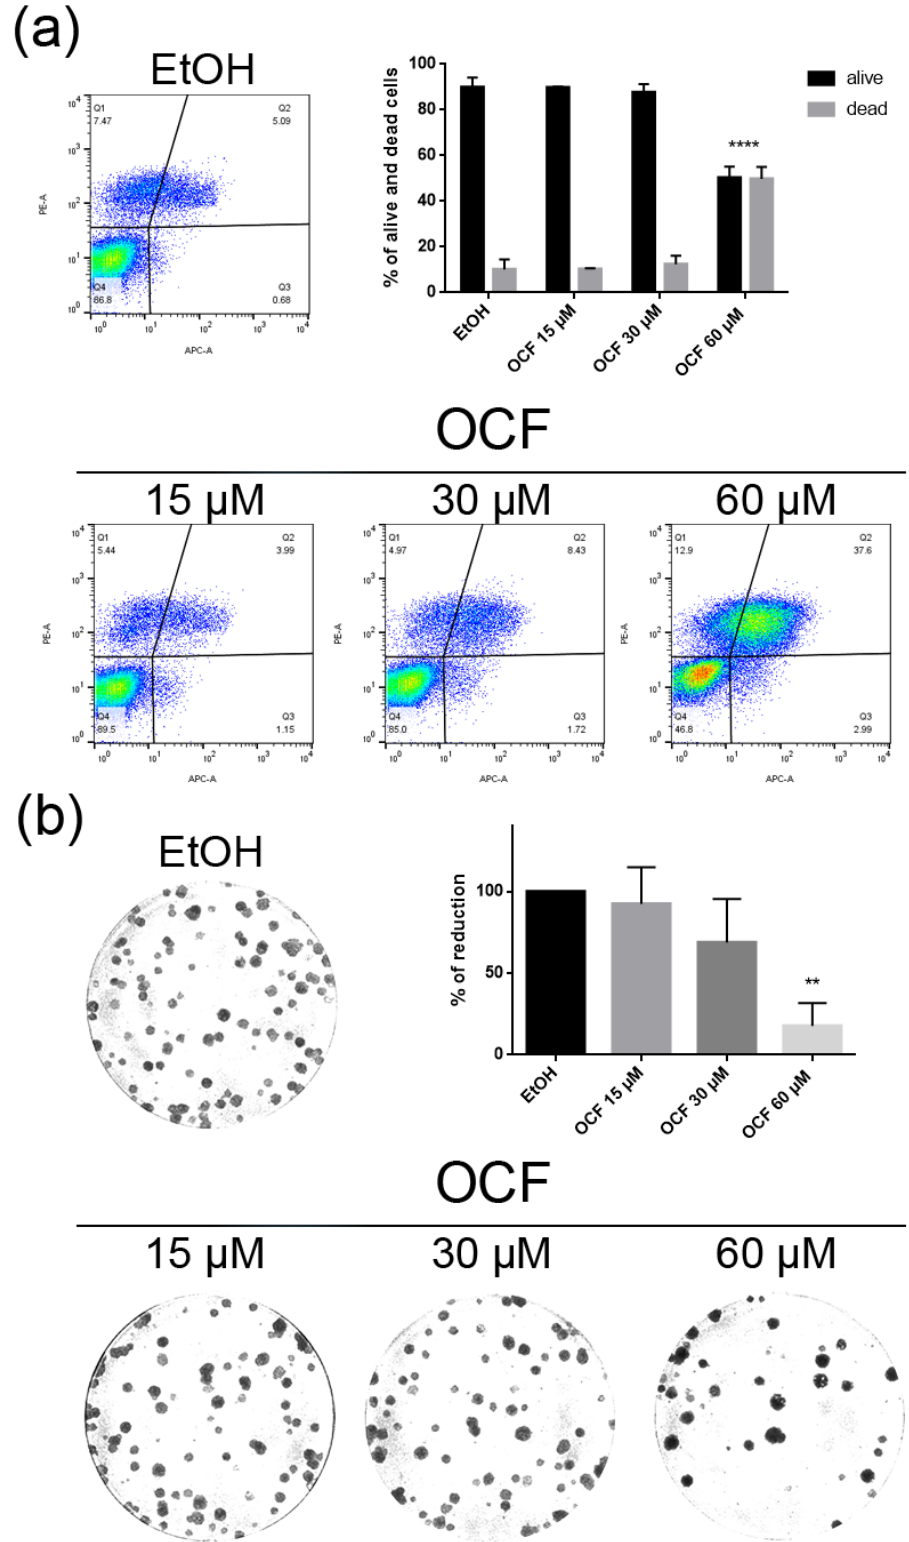
Figure 3. Vitality and colony formation assay of the OCF-treated AGS wt cells. AGS wt cells were treated for 72 h with vehicle or different doses of the OCF; plots and corresponding histograms for the live/dead cells percentages obtained using annexin V/PI double staining, are shown ( a ). Cell colonies obtained after 72 h of the vehicle/OCF treatment and corresponding percentage quantification ( b ).